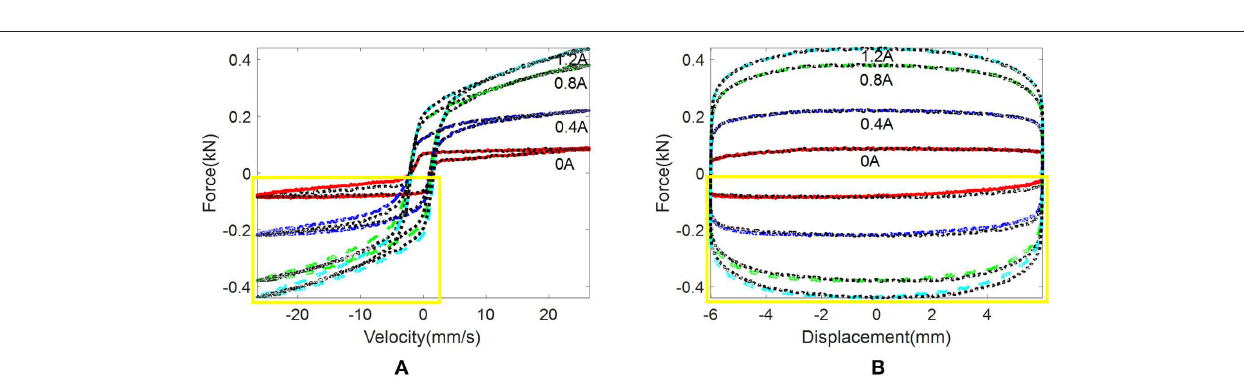
Frontiers in Materials |